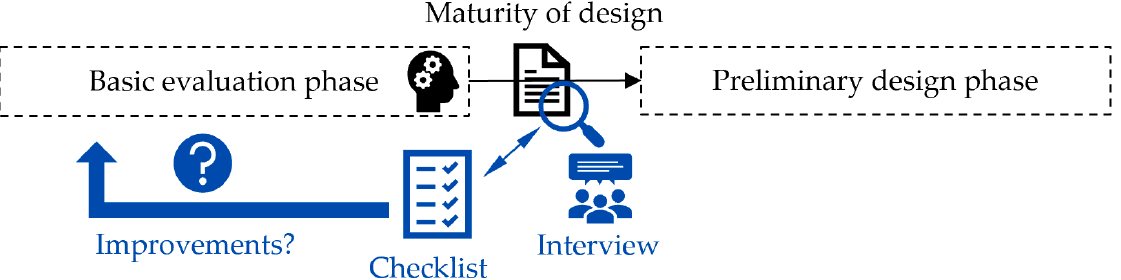
Figure 15. Set-up for evaluating the developed checklist.